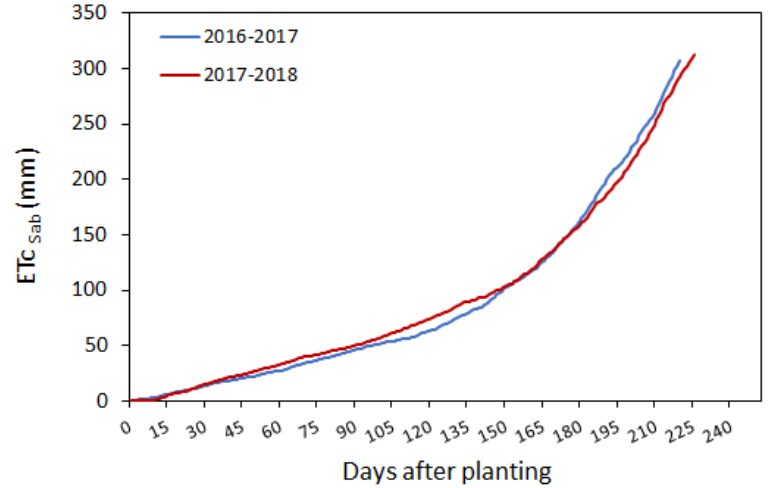
Figure A2. Variation of cumulated ET cSab during the 2016–2017 and 2017–2018 cropping